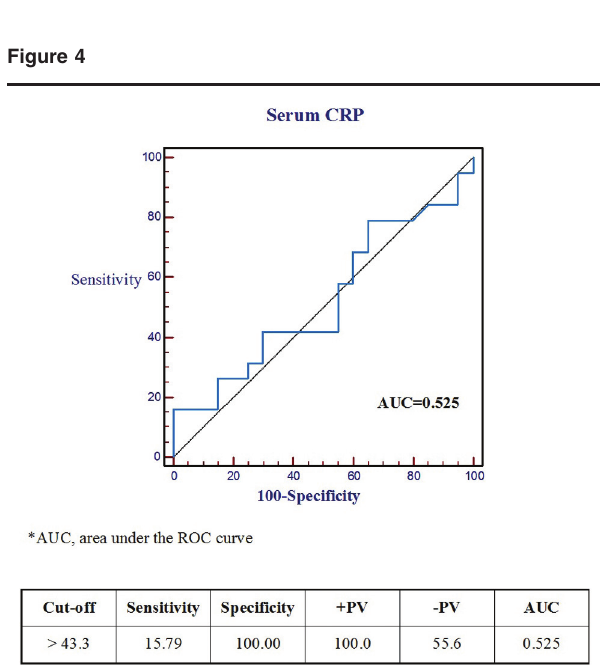
Diagnostic accuracy of serum C-reactive protein (CRP) in differenti- ation between tuberculous and malignant pleural effusion.